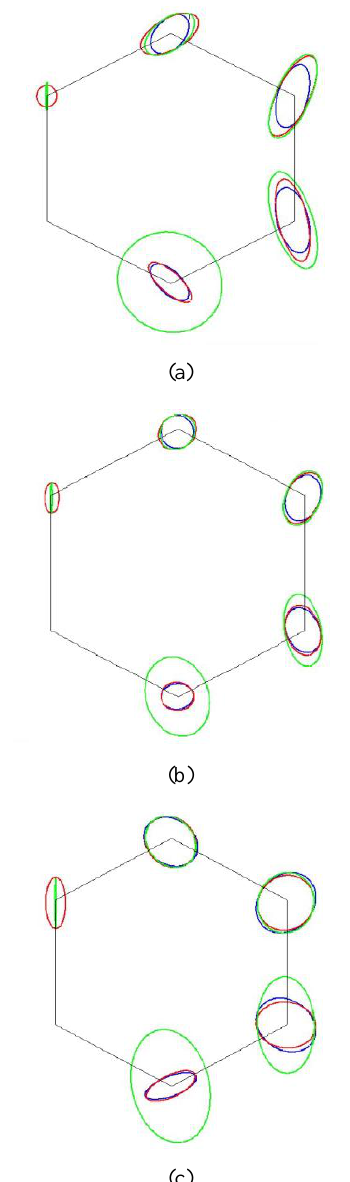
Figure 5. Error ellipses for results obtained from three adjustment methods of Transit (shown in green), Bowditch (shown in red) and the Least Squares (shown in blue) for simulated data for a square grid with a side length of one kilometer. In case a, an observation error of 5cm for the lengths and 40 seconds for the angles, in case b, an observation error of 10cm for the lengths and 20s for the angles, and in case c, an observation error of 20cm for the lengths and 10s for the angles was considered. Error ellipses are magnified by 1000 times.